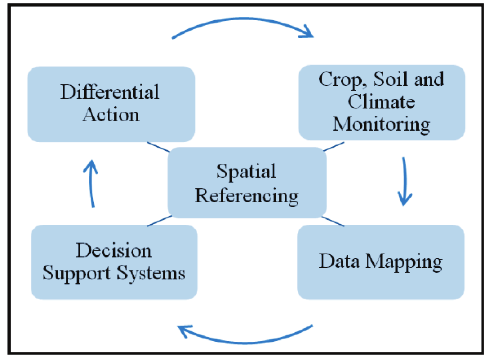
Fig. 1. Idea of precision